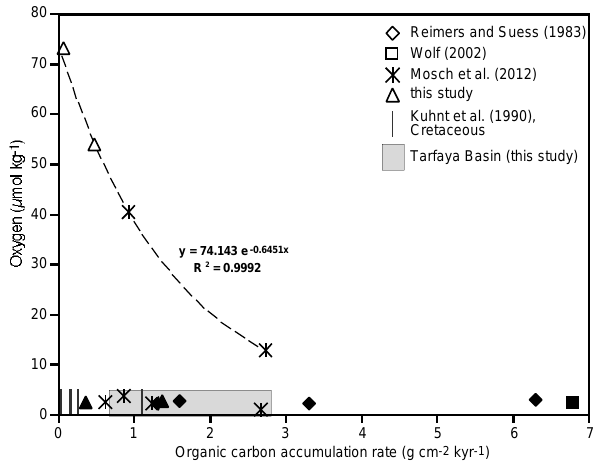
Figure 4. Organic carbon accumulation rates versus bottom-water oxygen. Filled symbols indicate laminated sediment